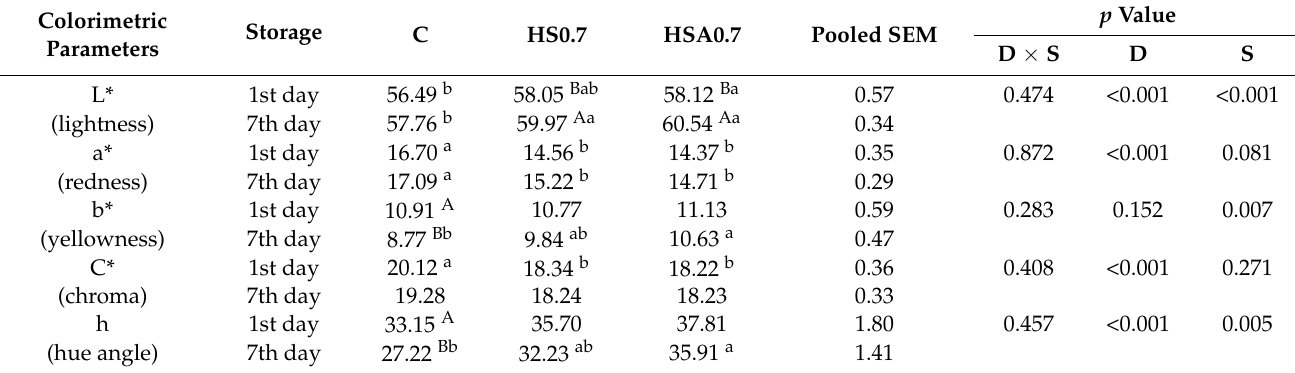
Table 6. The results of instrumental colorimetric analysis of breast meat samples during storage. Colorimetric